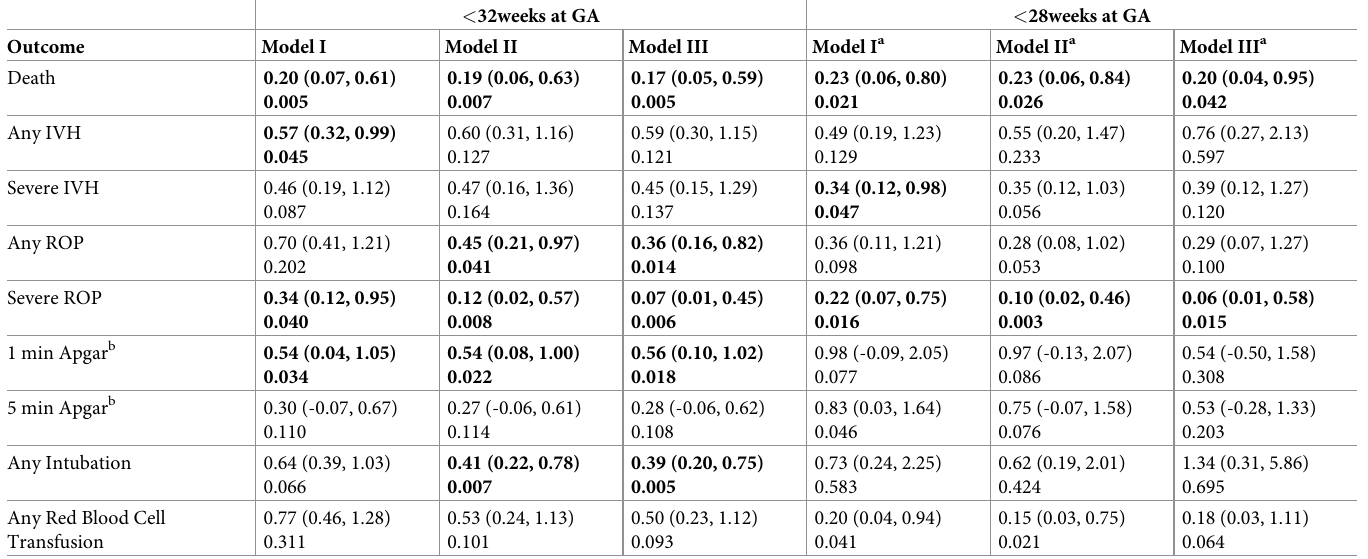
Table 3. Multivariate logistic regression analysis of neonatal